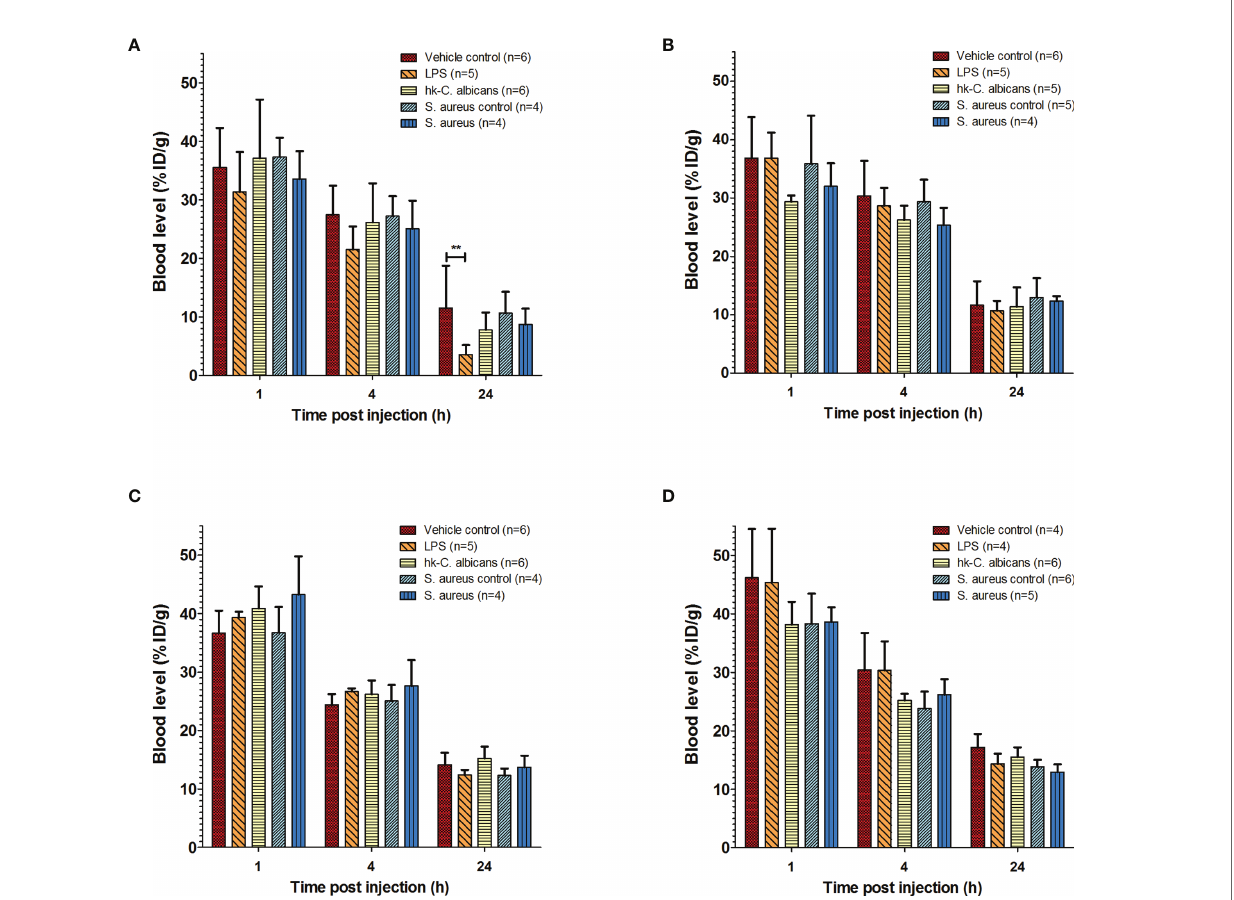
FIGURE 1 | Pharmacokinetics of 111 In-mPD-L1 and 111 In-IgG2a in a range of infection models. Pharmacokinetics of 30 µg of 111 In-mPD-L1 (A) , 100 µg of 111 In- mPD-L1 (B) , 30 µg of 111 In-IgG2a (C) , and 100 µg of 111 In-IgG2a (D) in RenCa tumor-bearing BALB/c mice immune stimulated with the following conditions: vehicle control, LPS, Hk- C. albicans , Staphylococcus aureus i.m. infected, and vehicle i.m. control. 111 In-mPD-L1 and 111 In-IgG2a blood concentrations 1, 4, and 24 h post antibody injection are given in % injected dose per gram of blood (%ID/g). Differences in blood levels were tested for signi fi cance using two-way ANOVAs with a Bonferroni post-hoc test (**p < 0.01) (see legend in fi gure for number of animals per group). LPS, lipopolysaccharide; Hk- C. albicans , heat-killed Candida albicans